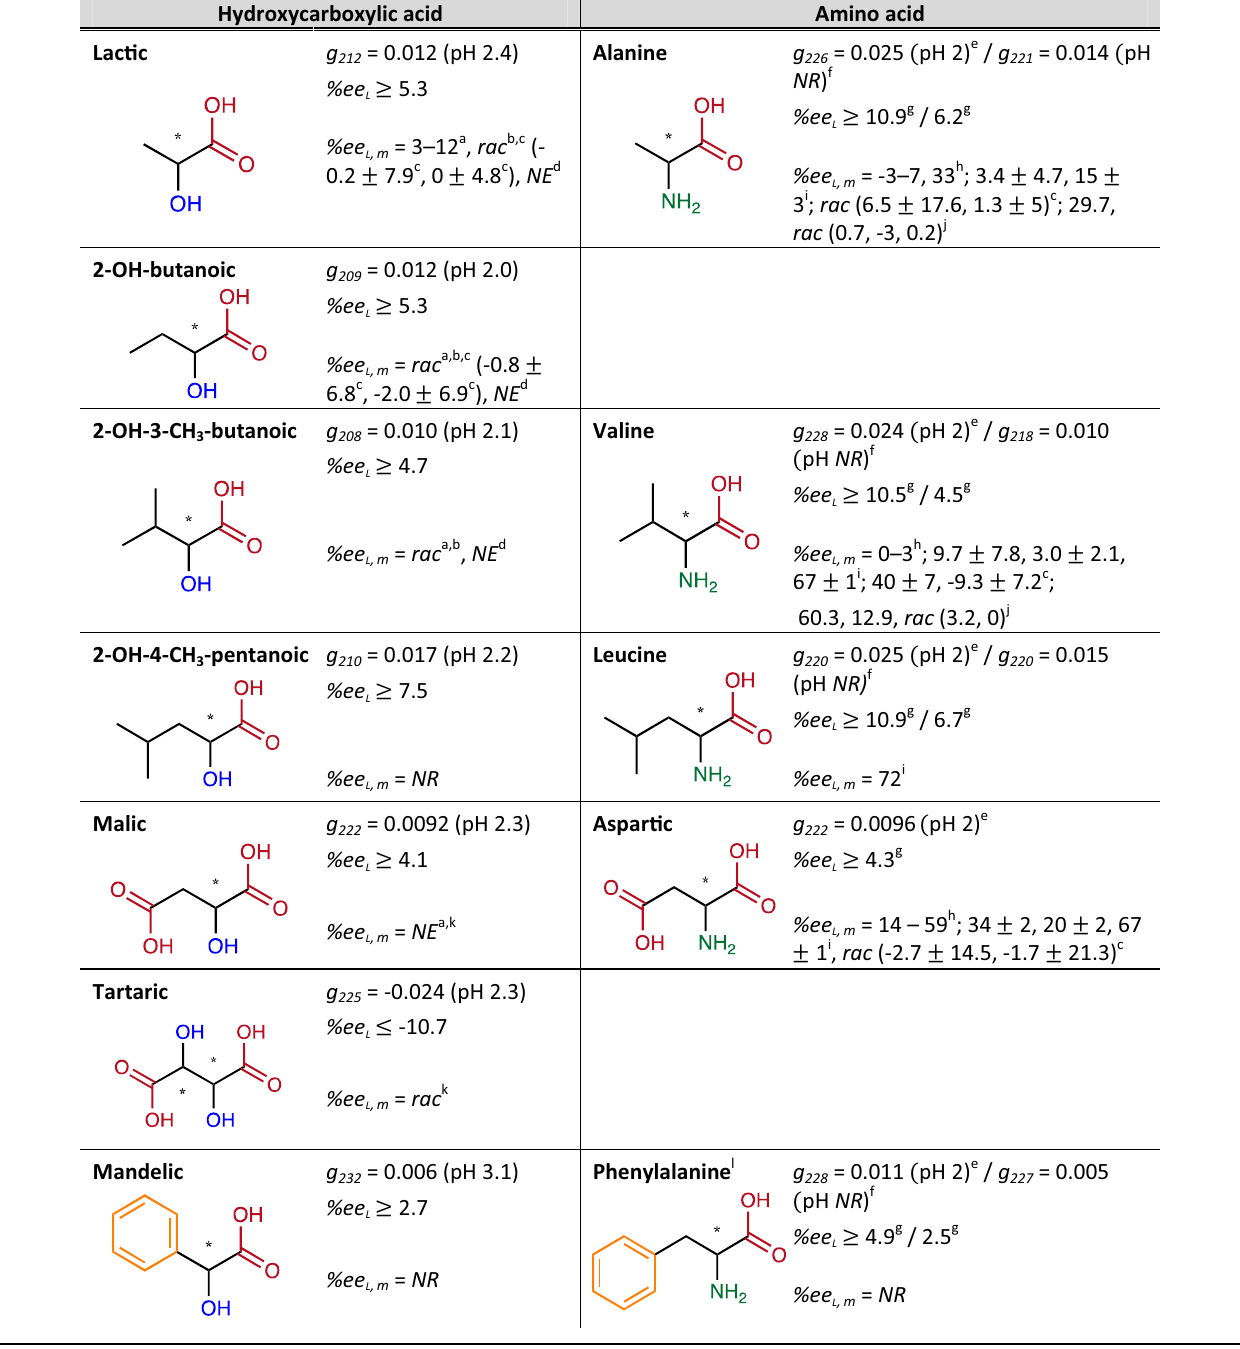
Table 1 Comparison of the hydroxycarboxylic acids ’ anisotropy factors g (extremum wavelength) in aqueous solutions of given pH, corresponding %ee values at the extent of reaction ξ = 0.9999 calculated based on relation (1) and %ee L in different meteoritic samples with those previously reported for amino acid